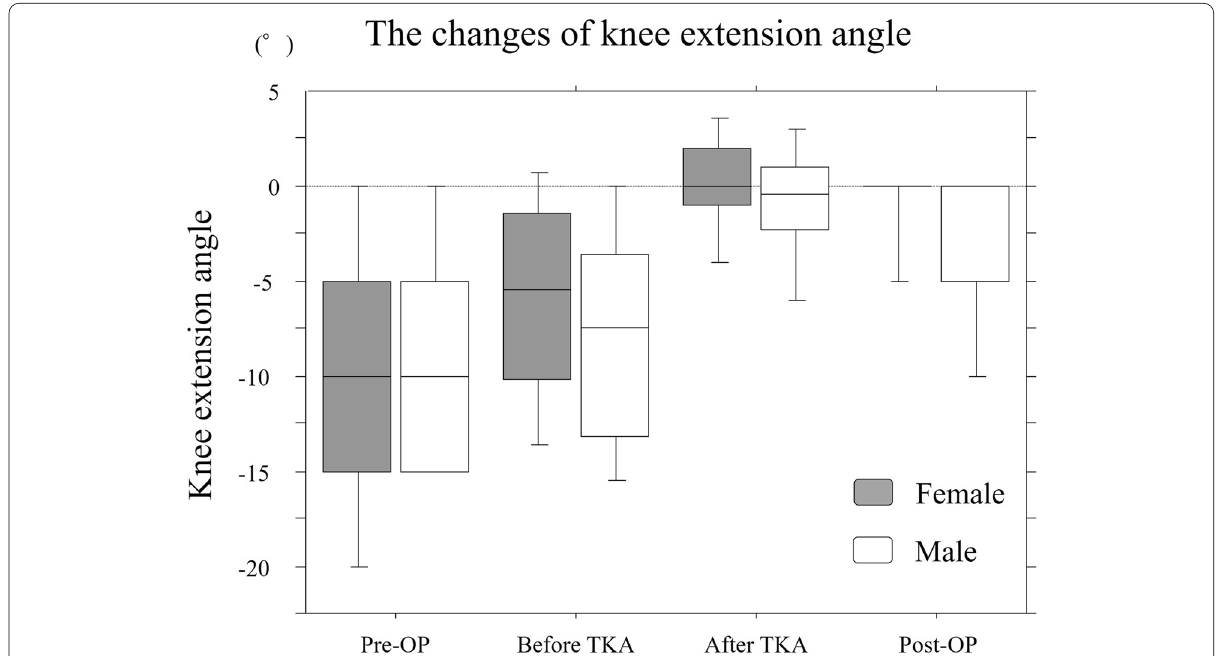
Fig. 2 Boxplot and whisker plot of the mean knee extension angle. Pre-OP, preoperative knee extension angle; Before TKA, Intraoperative maximum knee extension angle before TKA; After TKA, Intraoperative maximum knee extension angle after TKA; Post-OP, postoperative knee extension angle at 6 months after